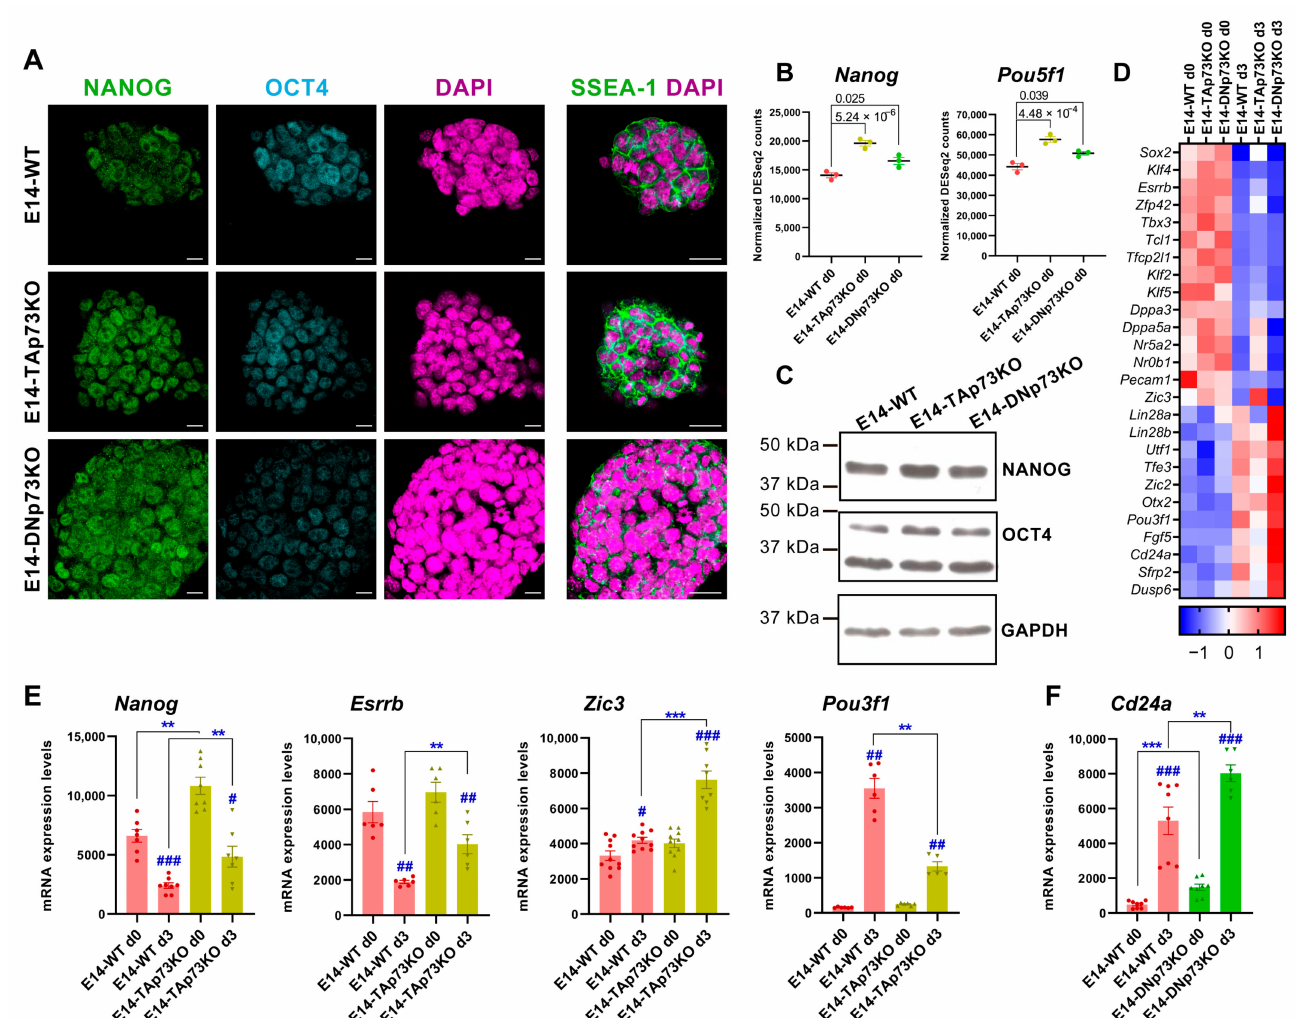
Figure 7. Lack of p73 isoforms predisposed naïve pluripotent mESC to transition into primed cells in an isoform-specific manner. ( A ) Confocal microscopy analysis of pluripotency markers NANOG (green), OCT4 (blue) and SSEA-1 (green). DAPI (purple) was used to visualize nuclei. Scale bars: 20 µ m. ( B ) Expression plots showing normalized DEseq2 counts for Nanog and Pou5f1 from E14-WT and p73-isoform-specific KO samples under basal conditions (S/L, day 0). p-adj values are indicated. ( C ) Western blot analysis of NANOG and OCT4 protein levels in E14-WT and p73 isoform-specific KO cells. GADPH was used as loading control. ( D ) Heatmap visualization of RNA-Seq expression Z-scores for regulatory genes of core and naïve pluripotency, as well as markers of transition and primed pluripotency in E14-WT and p73 isoform-specific KO samples from day 0 and day 3. Average values for each condition are plotted. ( E , F ) Analysis of pluripotency markers by qRT-PCR in E14-TAp73KO ( E ) or E14-DNp73KO ( F ) cells. # p -value < 0.05, **, ## p -value < 0.01, ***, ### p -value <